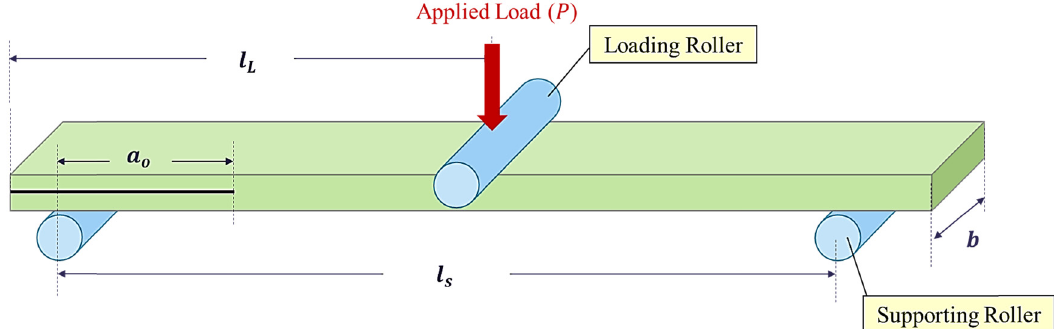
Figure 1: Schematic of a tested sample.